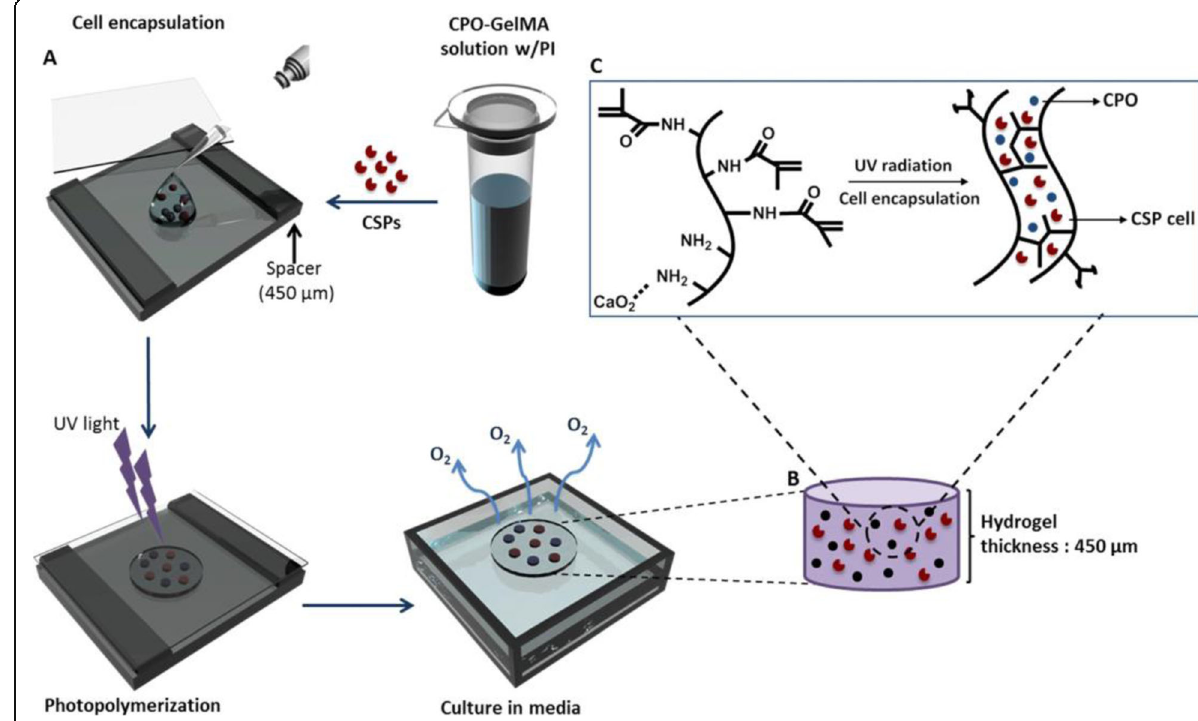
Fig. 8 Preparation steps of CPO-based GelMA hydrogels. a CPO-GelMA is mixed with CSP and placed in a mold, then the mixture is cross-linked into a hydrogel using UV light. b Schematic representation of the CPO-GelMA. c its chemical structure. Reproduced with permission